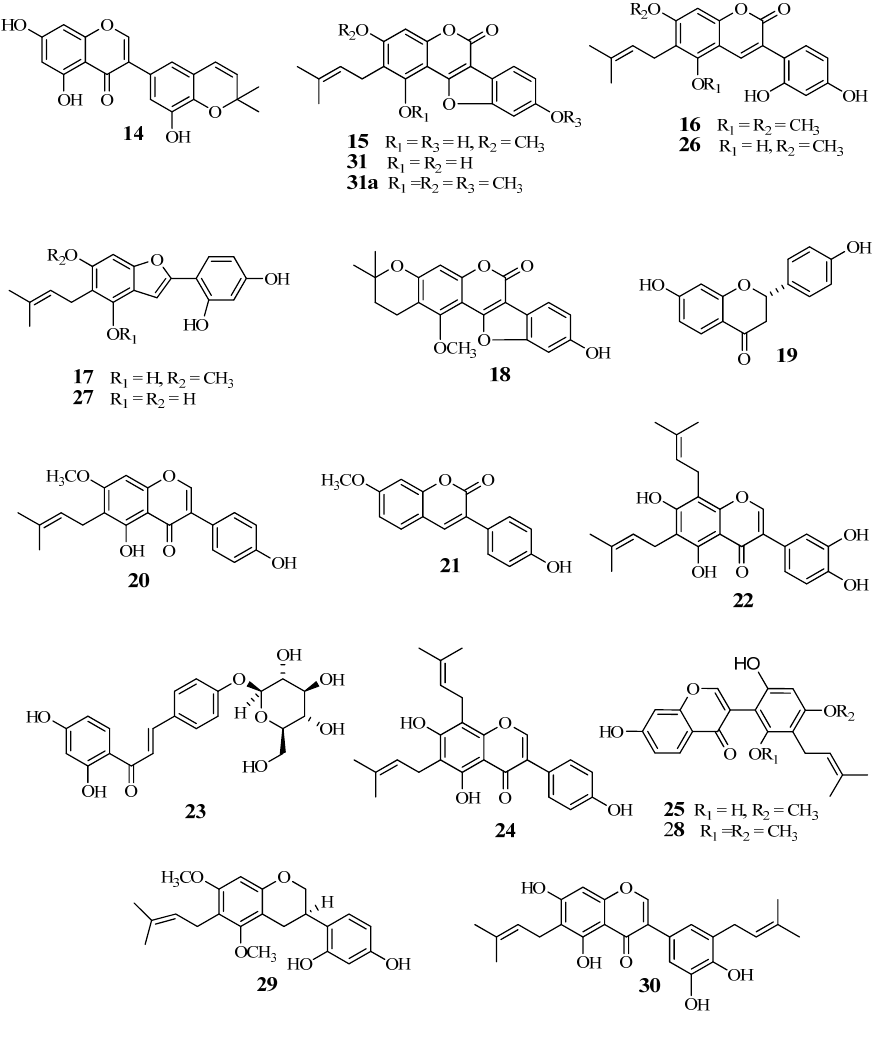
Figure 2. Chemical structures of compounds 14 ‒ 31 isolated from root and stolon of Glycyrrhiza uralensis